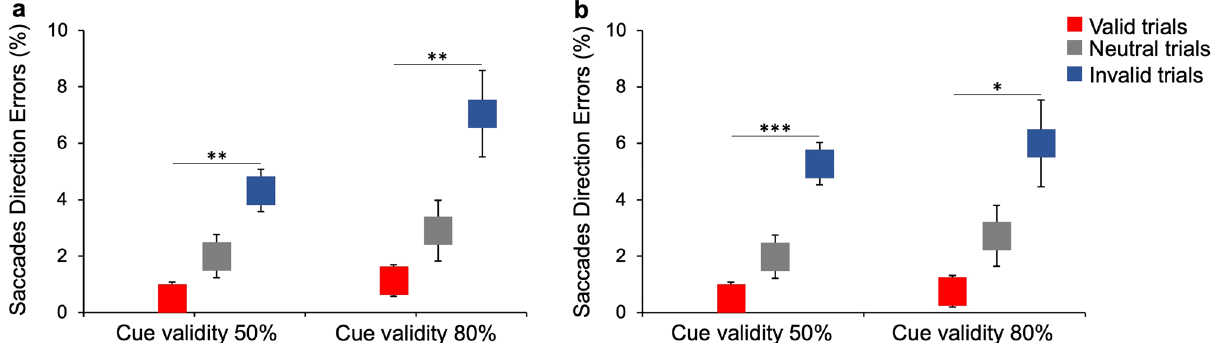
Figure 5. Percentage of saccadic direction errors in neutral, valid, and invalid trials. (a) Experimental condition. Post-hoc Conover tests (Bonferroni corrections) show that the percentage of saccades direction errors in valid trials (red) is lower than that in invalid trials (blue) for 50% ( t (11) = 4.05, p < 0.01) and 80% cue validity ( t (11) = 4.02, p < 0.01). (b) Control condition. Post-hoc Conover tests (Bonferroni correction) show that the percentage of saccades direction errors in valid trials is lower than that in invalid trials for 50% ( t (11) = 5.02, p < 0.001) and 80% cue validity ( t (11) = 3.56, p < 0.05). Asterisks mark statistically significant pairwise comparisons across trial types: * p < 0.05; ** p < 0.01; *** p < 0.001. Error bars are